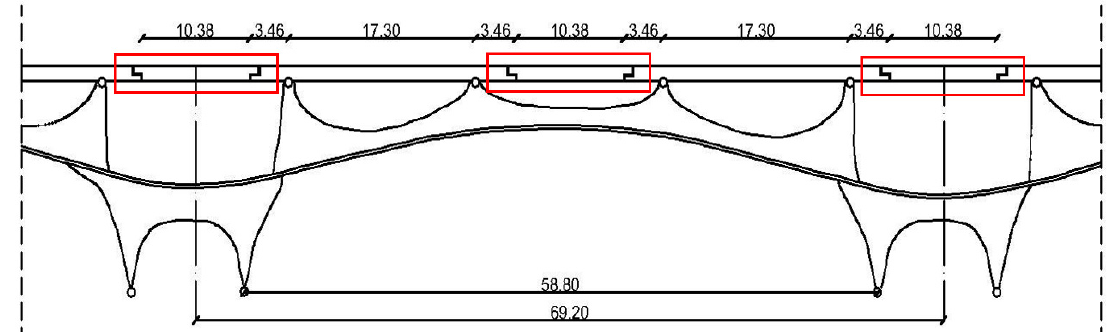
Figure 5. Scheme of a single bridge span and indication of simply supported sections (original sketch by Sergio Musmeci). Structural details of Gerber saddles are shown in Figure 6. Diagonal and horizontal 30 mm diameter reinforcement bars are present along with 10 mm diameter stirrups with variable spacing. Further, the corbels are provided with 10 mm diameter confining hoops spaced 50 mm and placed in the two orthogonal directions with 20 mm cover. Horizontal rebars typically have 50 mm cover, while diagonal ones have 50 mm minimum cover near the corbel junction. More detailed schemes of reinforcement bars are shown in the